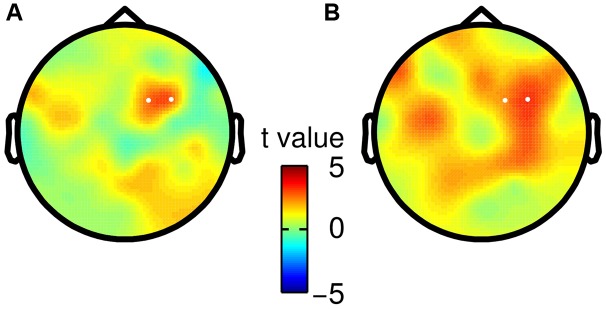
Scalp topographies of choice-selective beta band modulation for both saccade-to-choice mappings. White dots correspond to electrodes spanning the significant TF cluster in the main analysis based on all participants. (A) Choices of “f2 > f1” were associated with a rightward saccade, whereas “f2 < f1” choices required a leftward saccade. (B) Opposite mapping as described in (A).